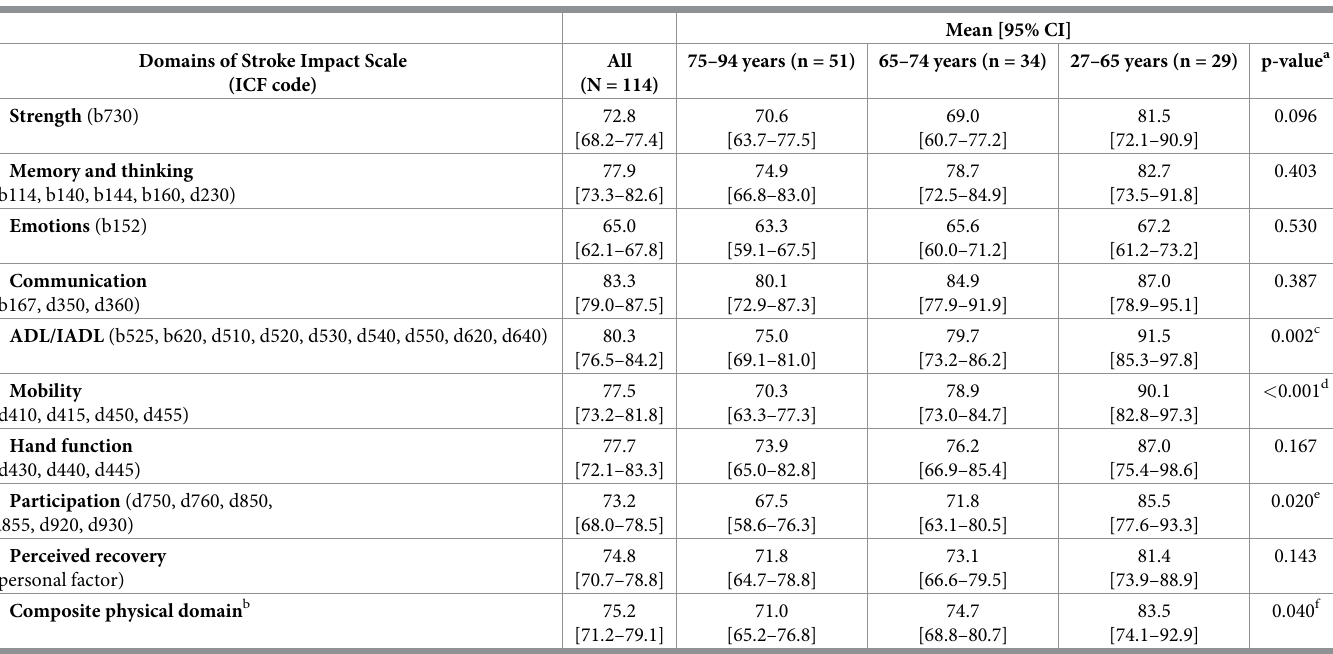
Table 5. Results from stroke impact